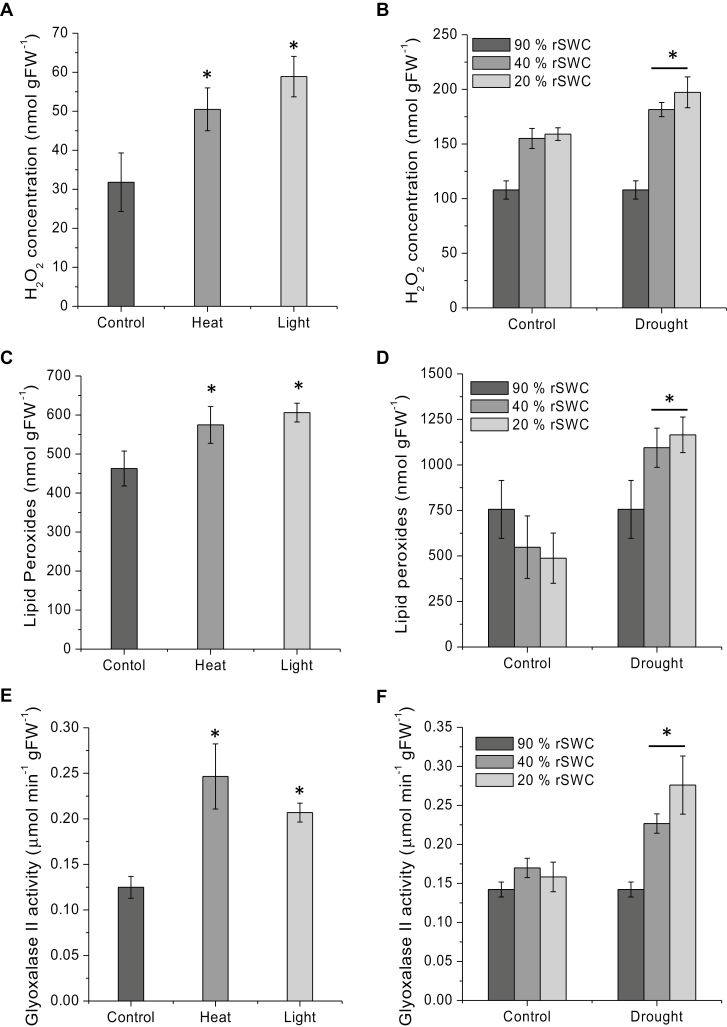
Analysis of stress response in Arabidopsis Col-0 plants under high light (IsoLight 850 µmol m−2 s−1), heat (37 °C, 78% humidity), and drought conditions. (A and B) H2O2 concentration (nmol gFW–1) measurements for (A) control, high light, and heat, and (B) drought stress treatments. H2O2 measurements were taken using homovanillic acid fluorescence by emission at 425 nm (excitation 315 nm) using an LS 50B fluorimeter. (C and D) Determination of lipid hydroperoxide content (nmol gFW–1) in (C) control, high light, and heat treatment, and (D) drought stress treatment. The concentrations were measured by ferrous oxidation-xylenol orange assay with absorption measurement at 560 nm using a Cary 60 UV-visible spectrophotometer. (Eand F) Glyoxalase II enzyme activity measurements of (E) control, high light, and heat, and (F) drought experiments. Measurements were taken with S-d-lactoylglutathione as substrate and the absorbance at 412 nm of DTNB was measured. * indicates a significant difference at P<0.05.